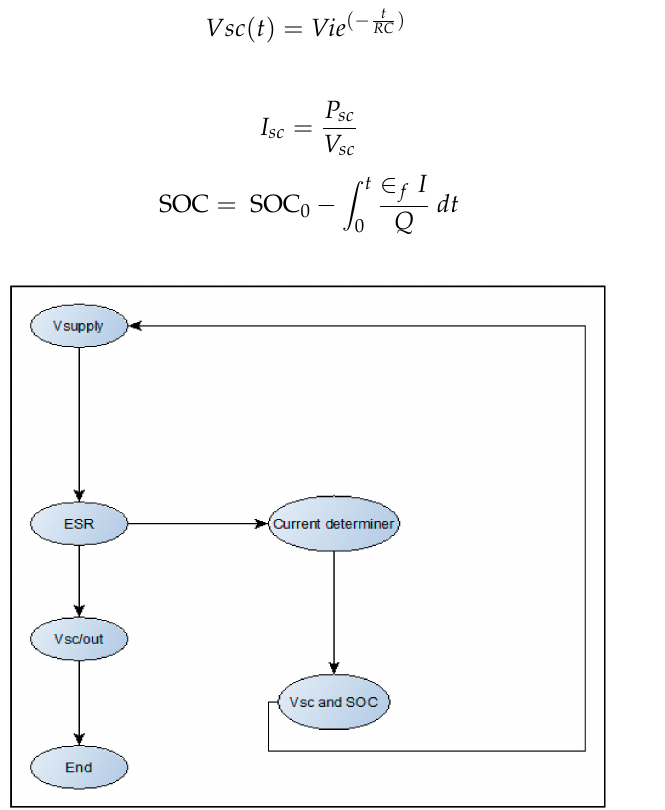
Figure 4. Supercapacitor model developed in